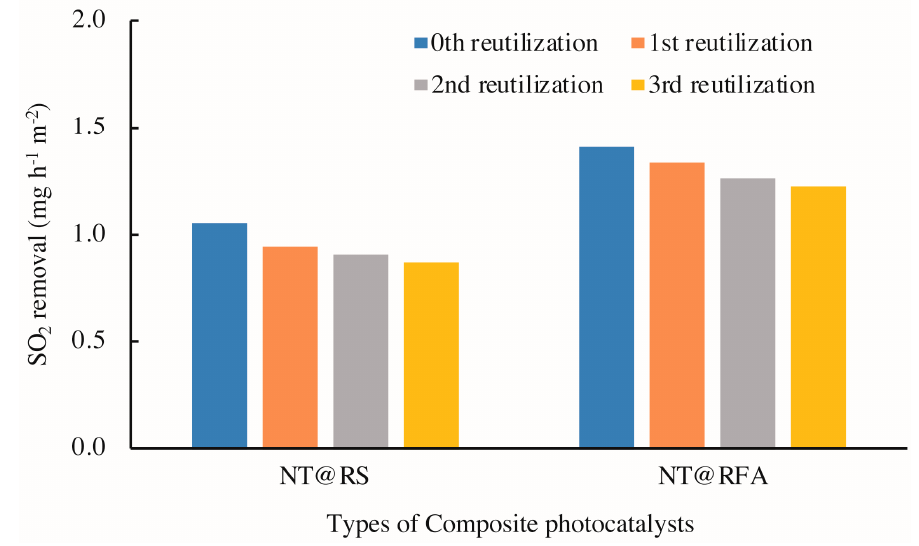
Figure 11. SO 2 degradations of different samples: reused 0–3 times.